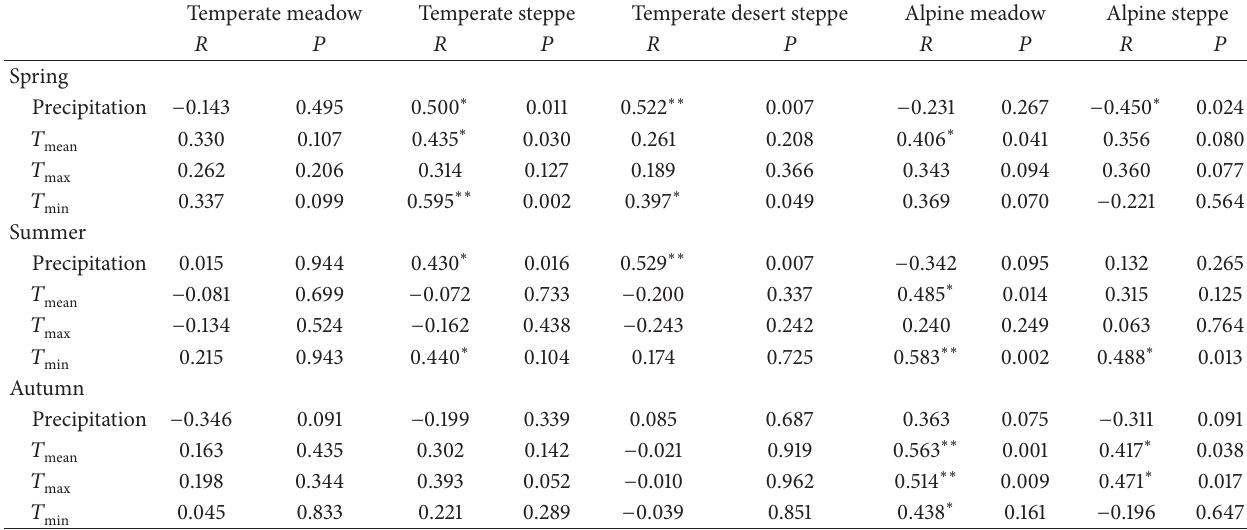
Table 2: Correlation coefficients ( 𝑅 ) and two-tailed significance test values ( 𝑃 ) between seasonal mean NDVI and precipitation or temperature in the same season for different grassland